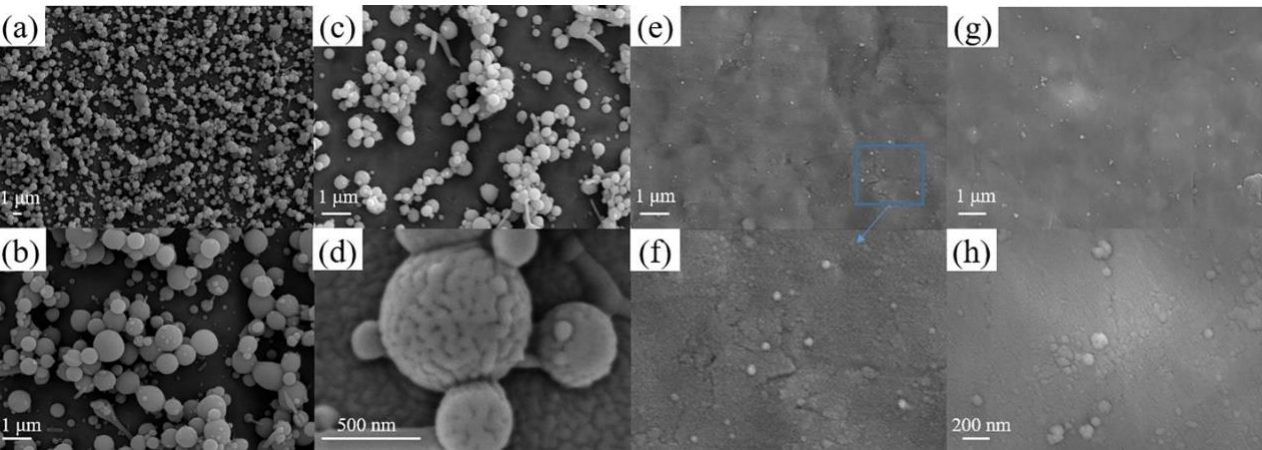
Figure 3. Morphologies of the produced particles under various conditions: ( a , b ) precursor particles by conventional EHDA device; ( c , d ) TiO 2 particles by calcinating the precursor particles; ( e , f ) particles prepared by electrospray pyrolysis with the ring grounded; ( g , h ) particles prepared by electrospray pyrolysis with a ring voltage of 500 V.